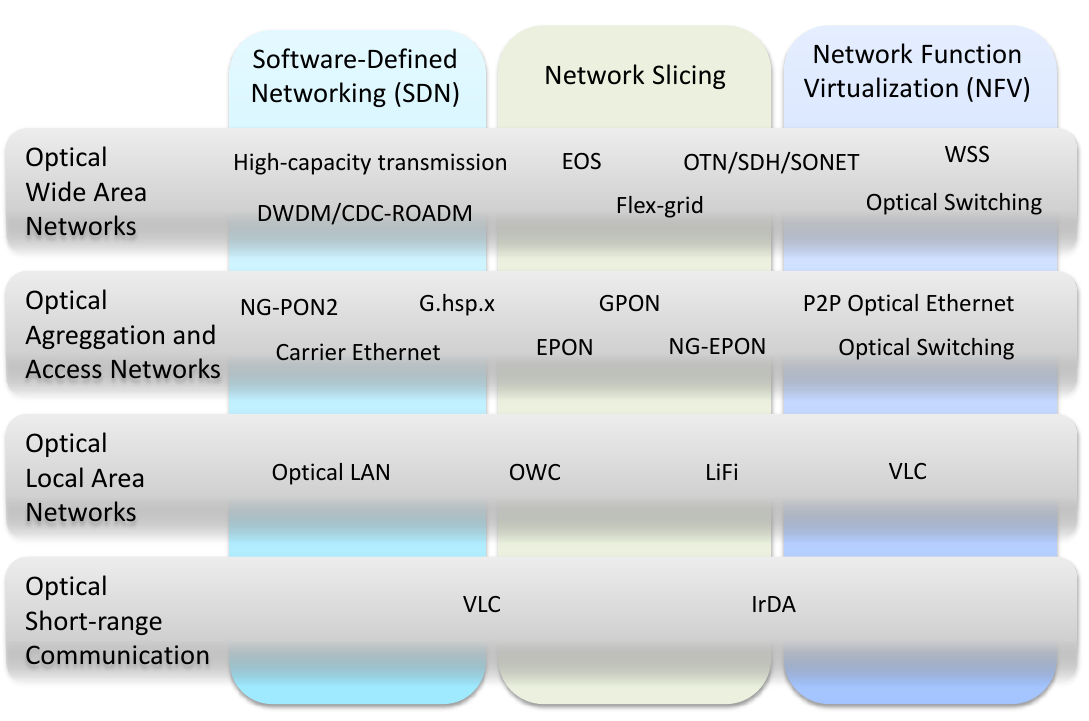
Figure 5. Summary of advanced optical communication technologies and approaches (DWDM: Dense Wavelength-Division Multiplexing, CDC-ROADM: Colorless Directionless Contentionless-Reconfigurable Optical Add-Drop Multiplexer, OTN: Optical Transport Networks, SDH: Synchronous Digital Hierarchy, SONET: Synchronous Optical Networks, EOS: Elastic Optical Networking, WSS: Wavelength Selective Switch, NG-PON: Next-Generation Passive Optical Network, NG-EPON: Next-Generation-Ethernet Passive Optical Network, P2P: Point-to-Point, OWC: Optical Wireless Communications, LiFi: Light Fidelity, VLC: Visual Light Communication, LAN: Local Area